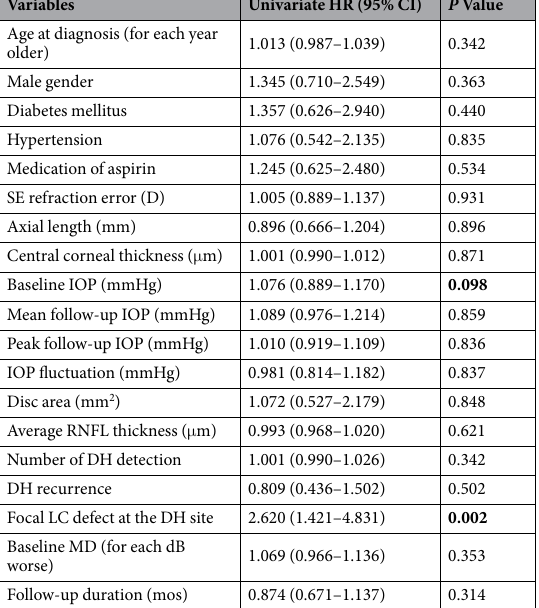
Table 3. Cox proportional hazards univariate analysis of visual field progression in glaucoma patients with disc hemorrhage. CI, confidence interval; HR, hazard ratio; D, diopters; IOP, intraocular pressure; RNFL, retinal nerve fiber layer; DH, disc hemorrhage; LC, lamina cribrosa; MD, mean deviation; PSD, pattern standard deviation; VF, visual field. Variables with P < 0.10 are shown in bold.